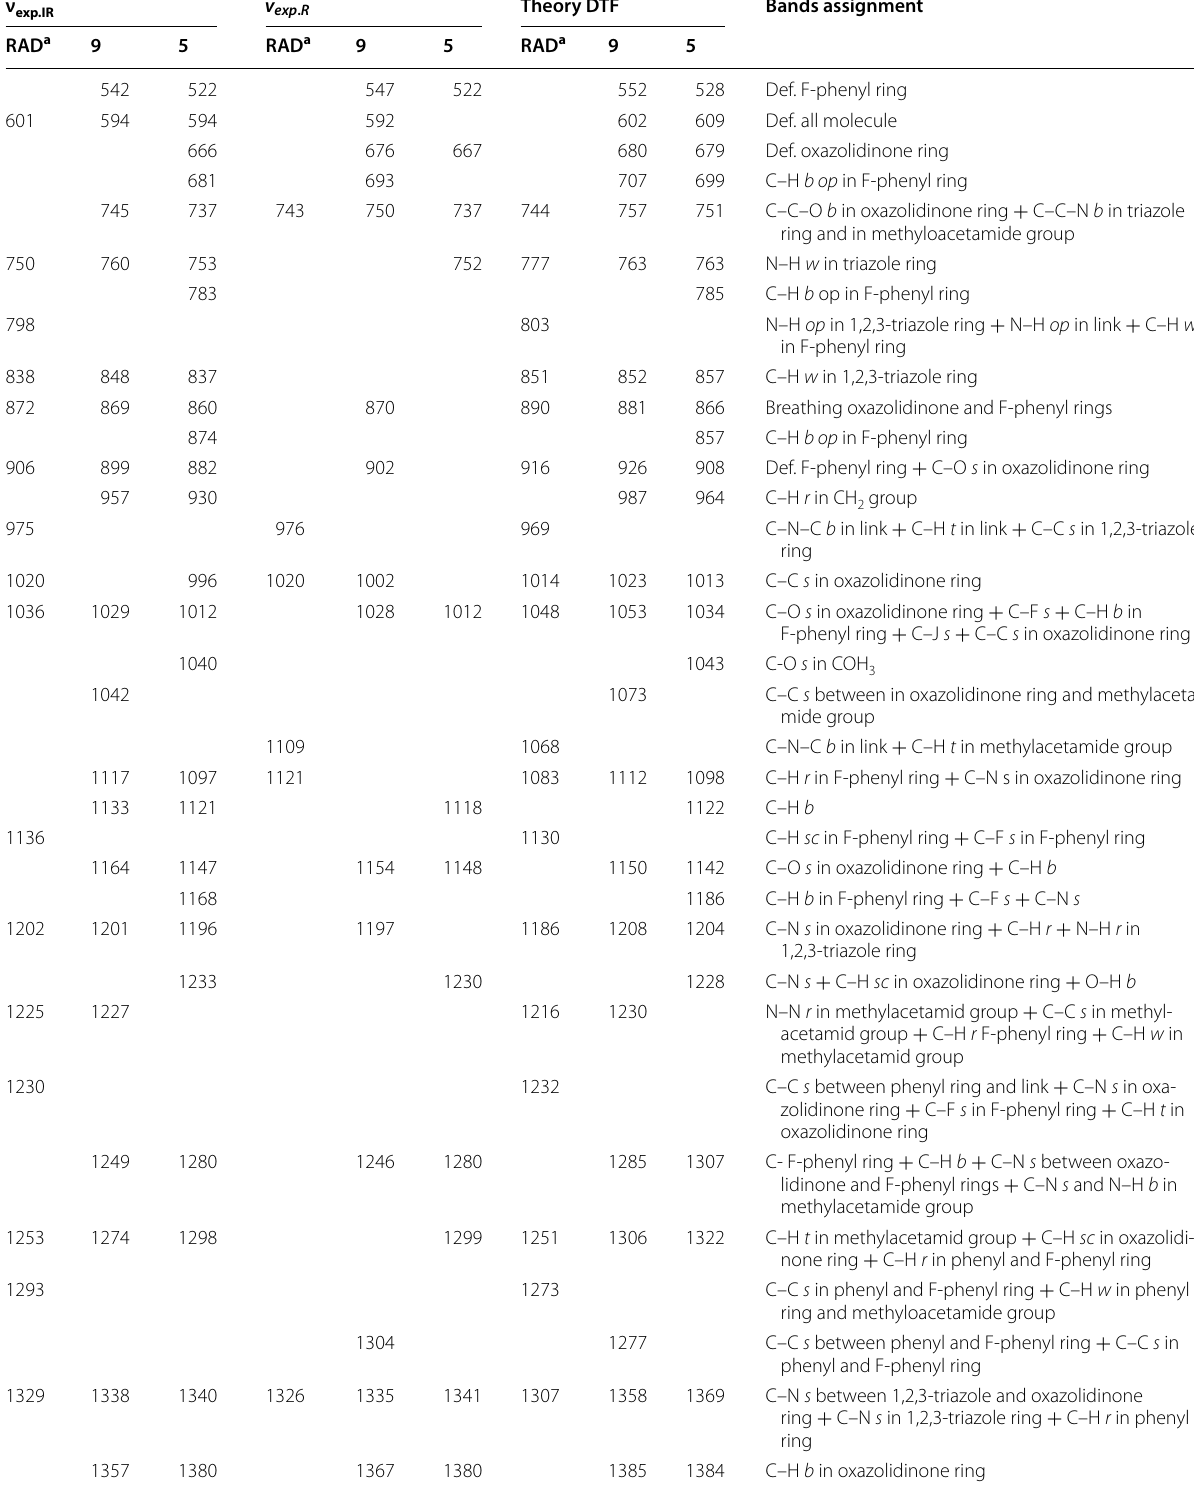
Table 1 Selected characteristic vibrionic features of RAD, 9 and 5 in theory with application of 6-311G(d,p) basis and experiment bands of 9 and